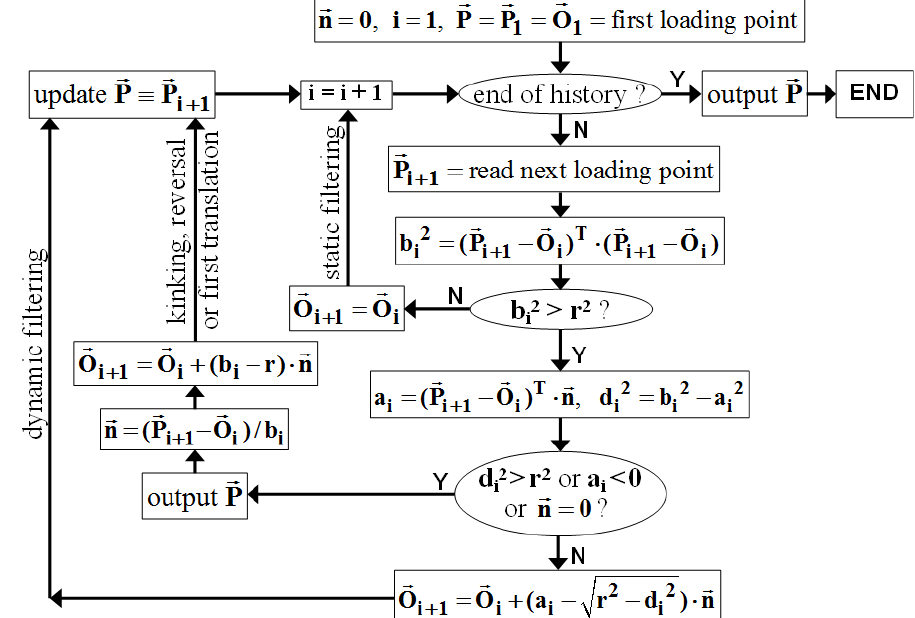
  output values, where n is